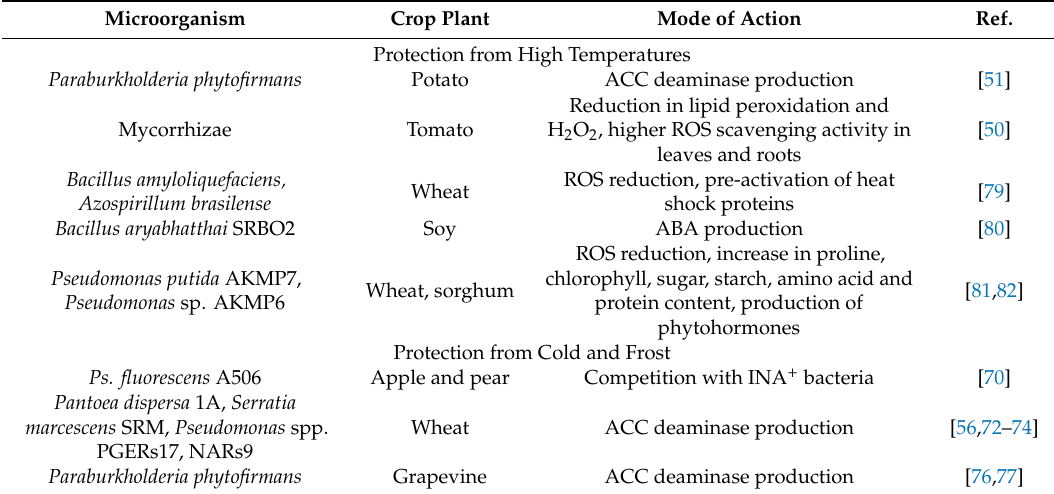
Table 1. Microorganisms used against stress induced by extreme thermal events. Microorganism Crop Plant